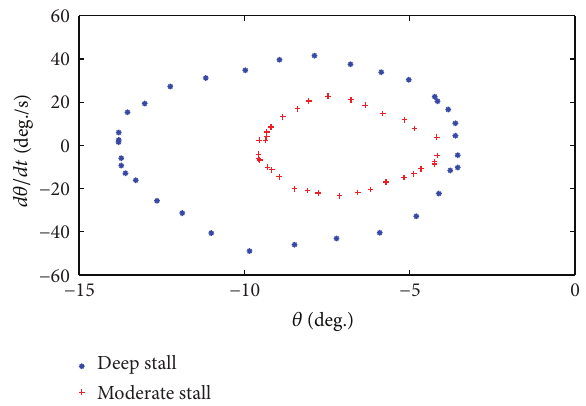
̇𝜃 of the system at moderate/deep